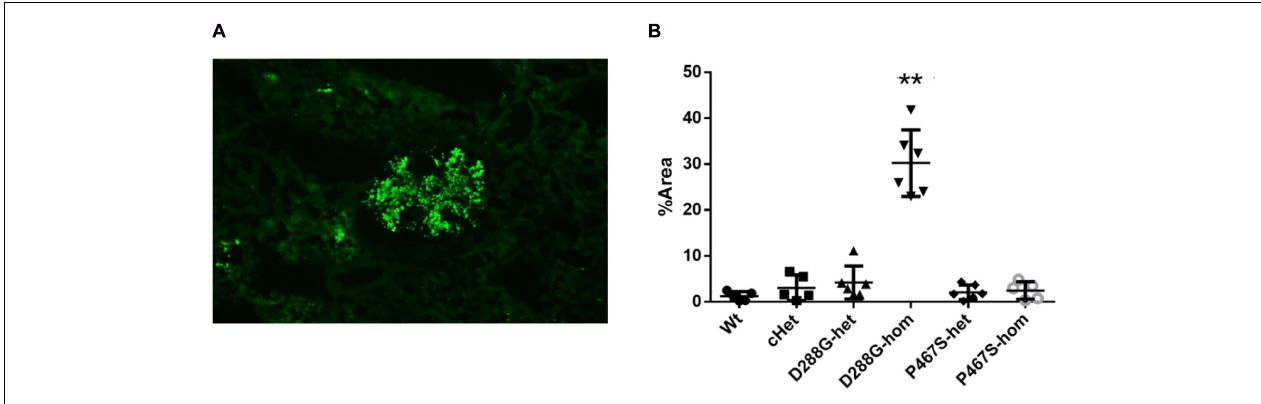
FIGURE 4 | Examination of C3 deposition in the kidneys of the mice treated by LPS. (A) An example of C3 staining pattern in mesangium. (B) Quantification and comparison of C3 staining intensity in the mice in the 6 groups. Wt, n = 5; cHet, n = 5; D288G-het, n = 6; D288G-hom, n = 6; P467S-het, n = 6; P467S-hom, n = 5. ** p = 0.0012 vs. wt according to the Kruskal-Wallis test with Dunn’s multiple comparisons.